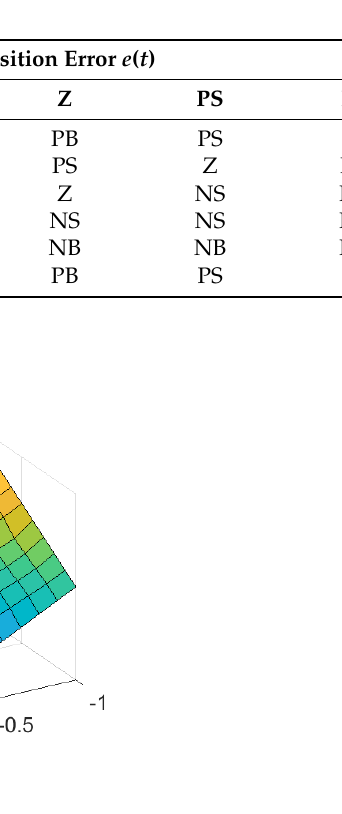
Figure 14. The output control surface describes the relationship between e ( t ), e ( t ), and U ( t ) based on the synthesis rule of the fuzzy rule base system for the fuzzy controller.